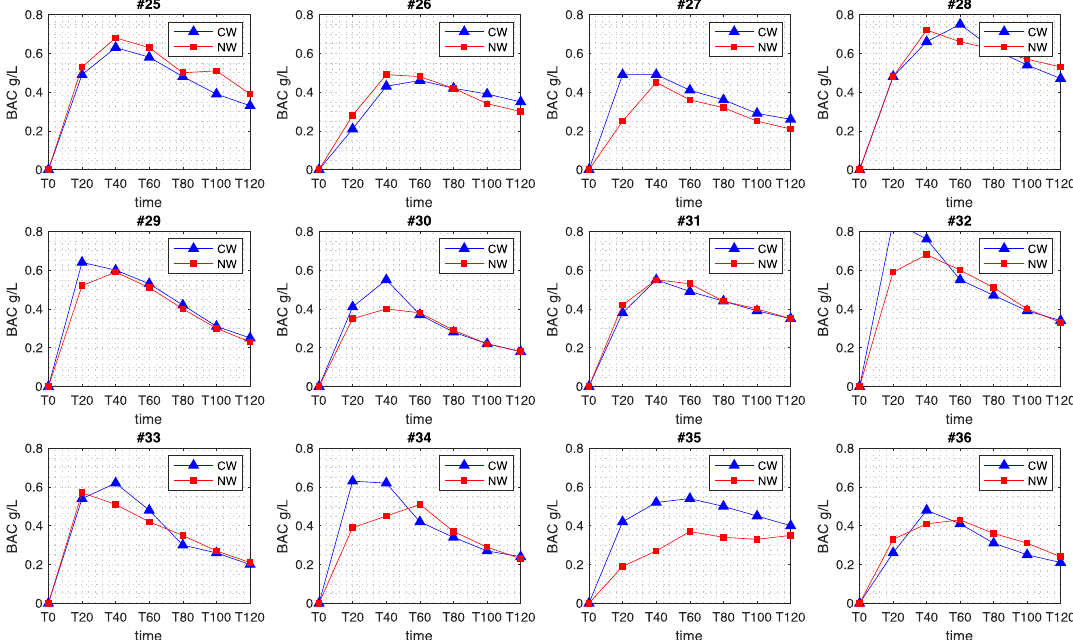
Figure A3. Concentration–time curves of BAC responses to natural wine and conventional wine for subjects #25 – #36.